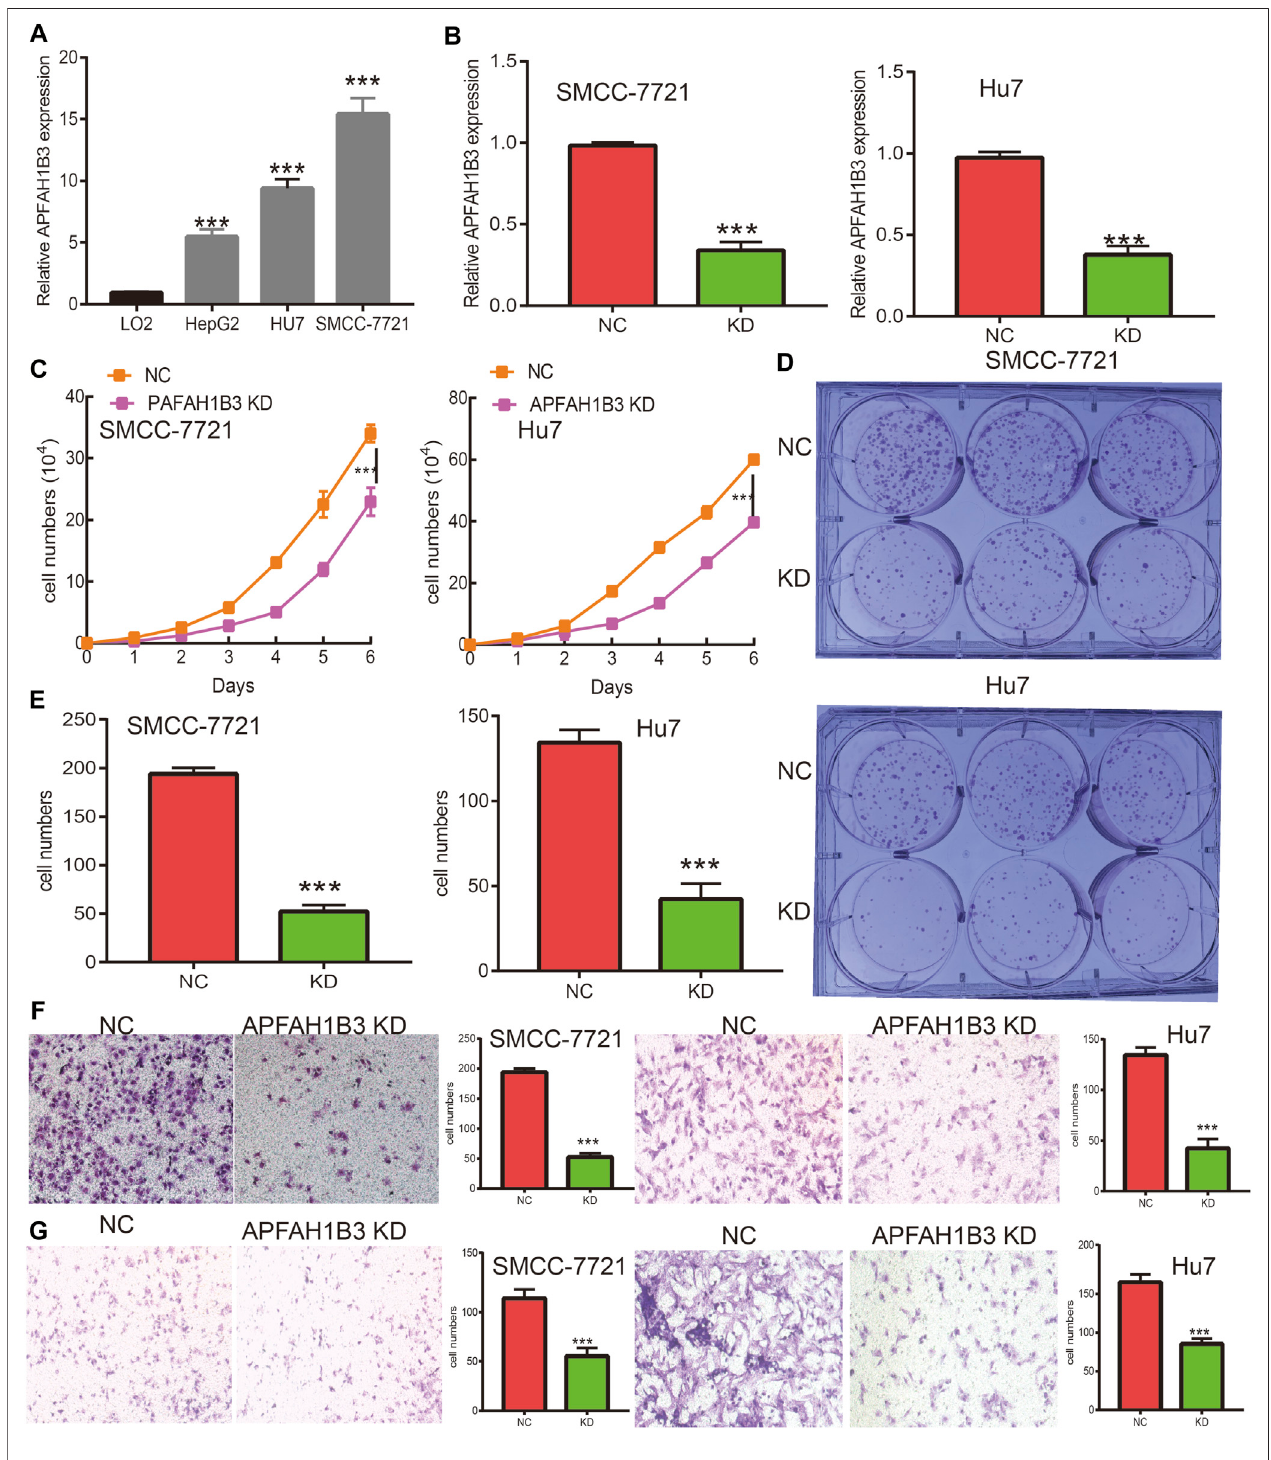
FIGURE 12 | Knockdown of PAFAH1B3 inhibits LIHC progression. (A) The expression PAFAH1B3 in LIHC cells lines was examined by qRT-PCR assay. (B) Establishment of PAFAH1B3 knockdown cell lines in SMC-7721 and Hu7 veri fi ed by qRT-PCR assay. (C) knockdown of PAFAH1B3 dramatically inhibits SMC-7721 and Hu7 cells proliferation examined by growth curve assay. (D – E) knockdown of PAFAH1B3 dramatically inhibits SMC-7721 and Hu7 cells colony formation ability. (F – G) knockdown of PAFAH1B3 dramatically inhibits SMC-7721 and Hu7 cells migration and invasion abilities.